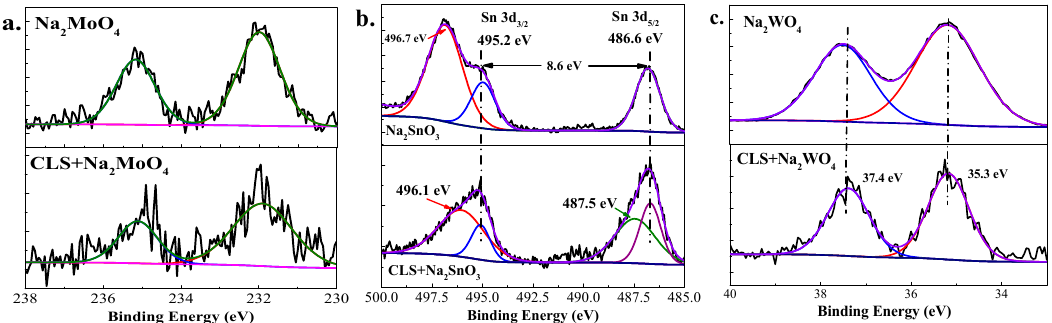
Figure 12. High-resolution X-ray photoelectron spectroscopy (XPS) spectrum of Mo 3d ( a ), Sn 3d ( b ), and W 4f ( c ) for inorganic inhibitor treated steel and CLS + inorganic inhibitor treated steel.